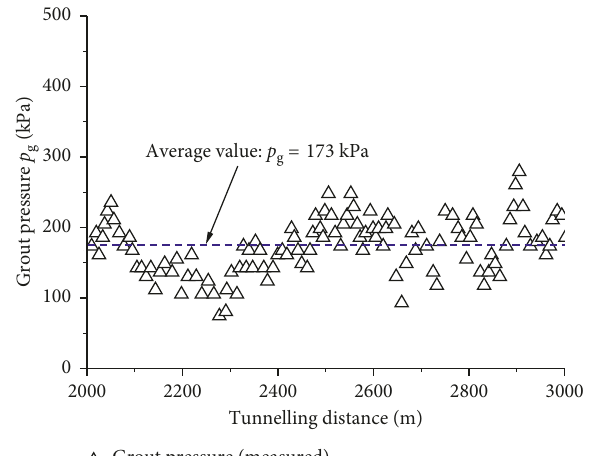
Figure 4: Grout pressure recorded in the case history (created based on [23]).